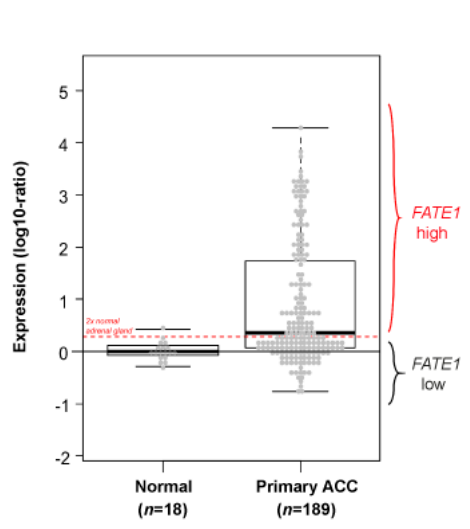
Figure 2. FATE1 expression in adult ACC. ( A ) FATE1 mRNA expression in cancers of the TCGA PANCAN dataset. 12,839 cases in total were analyzed using the Xena browser (https://xenabrowser.net). Tumor types are color-coded. ACC, adrenocortical carcinoma; KIRC,